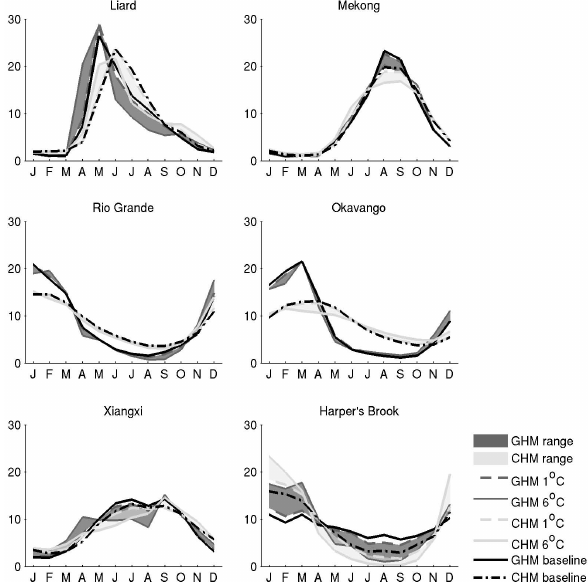
Fig. 6. Mean-monthly runoff, expressed as a percentage of the mean annual total runoff, simulated by the GHM and CHM re- spectively, for the baseline (black lines) and UKMO HadCM3 pre- scribed warming of 1 ◦ C and 6 ◦ C. The range in simulated runoff between 1 ◦ C and 6 ◦ C prescribed warming is